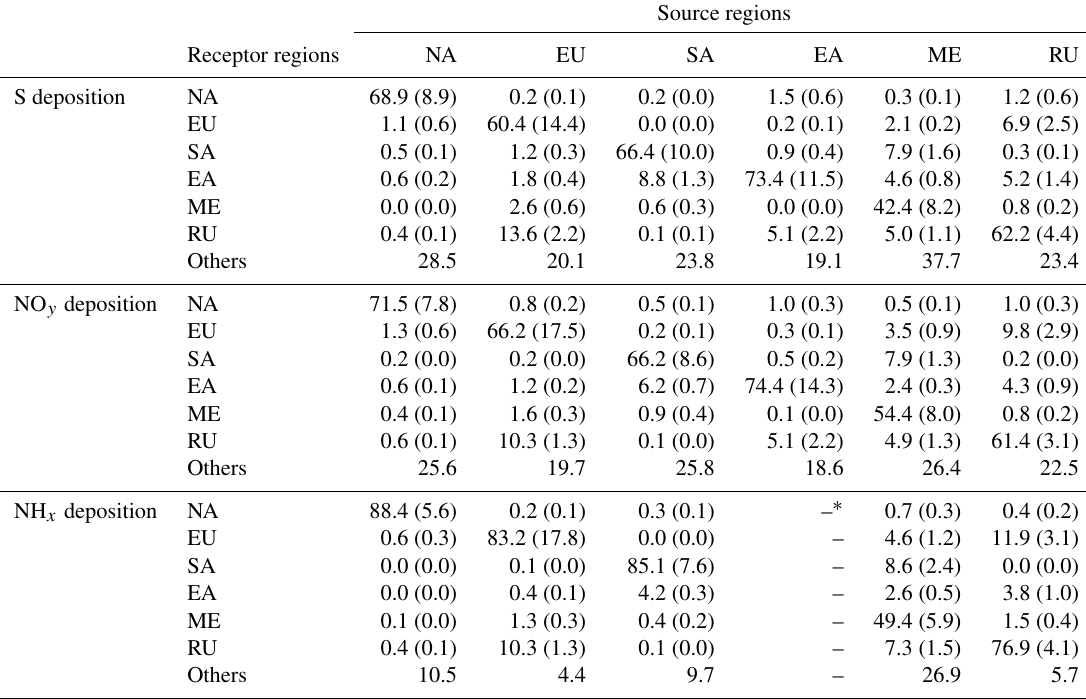
Table 1. Source–receptor relationship of S, NO y and NH x deposition (%) for regions (including continental coastal and non-coastal regions). The values in the parentheses are for coastal regions as a subset of the